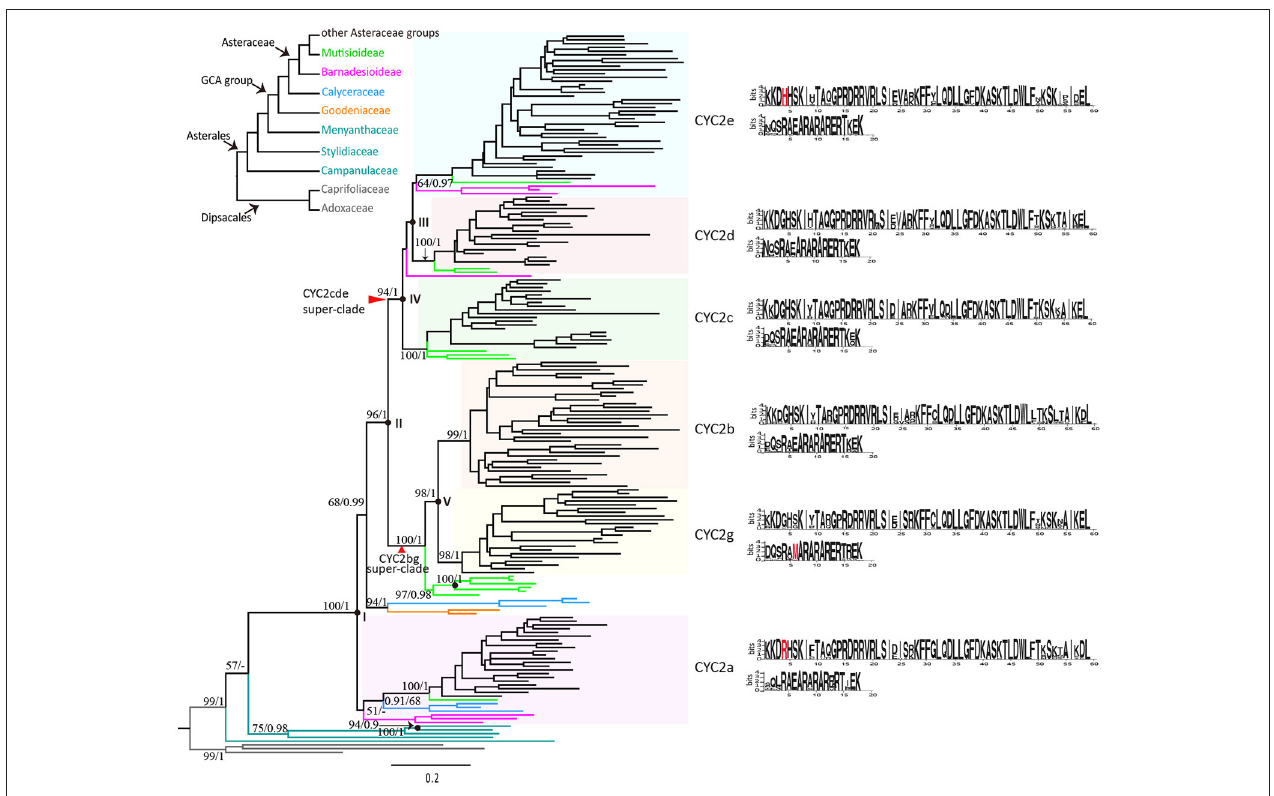
FIGURE 2 | Relationships of CYC2 -like genes in the Asterales based on 192 deduced amino acid sequences. The tree was constructed with Maximum Likelihood method (ML), using JTT I G F model by1000 bootstrap replicates and rooted by sequences of Dipsacales as the outgroup. Bootstrap supports (by ML)/Posterior + + + probabilities (by Bayesian Inference) are indicated above major branches. Black spots indicate gene duplication events; duplications within the Goodeniaceae-Calyceraceae-Asteraceae (GCA) group are labeled with roman letters I V. Consensus sequences of TCP and R domains for each of the six CYC2 ∼ clades based on MEME test are shown in the right, and clade-specific amino acid fixations are in red.